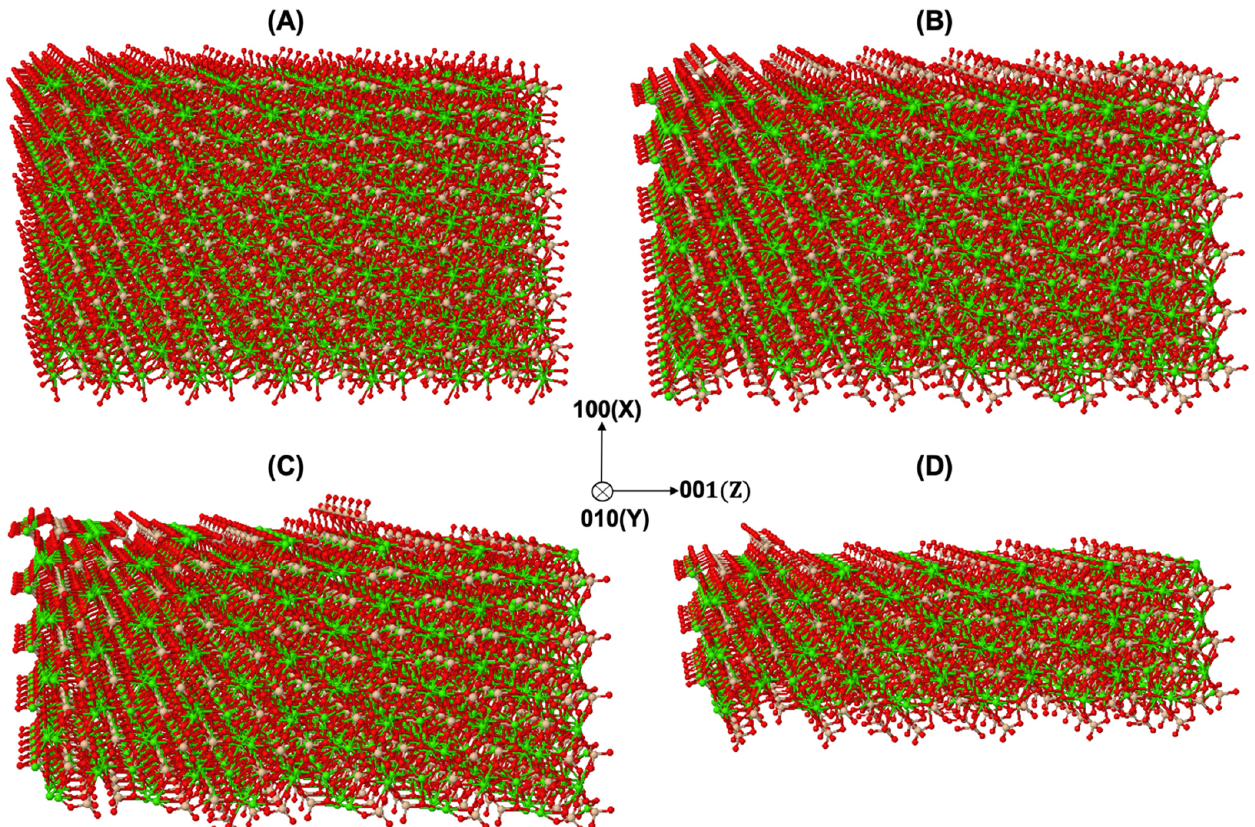
Figure 2. Evolution of β -C 2 S crystal during an atom-by-atom site dissolution KMC upscaling approach applied on the (100) and ( 100 ) facets. ( A ) Initial crystal morphology of β -C 2 S, consisting of 2724 sites. ( B – D ) Running of 272, 545, and 1362 dissolution steps resulted in dissolution of 10%, 20%, and 50% of the total number of crystal sites of the initial structure, respectively. Each step is representative of one site dissolution.